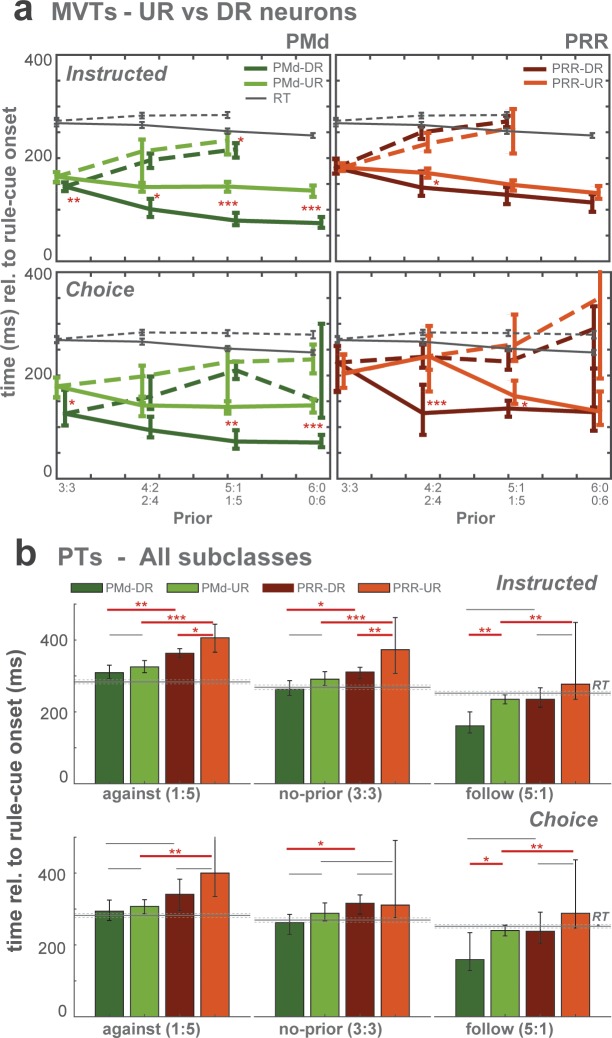
Selection-signal latencies between DR and UR neurons of PMd and PRR.(a) Comparisons of MVTs between DR and UR neurons in PMd (left) and in PRR (right). Instructed trials are shown on the left column and choice trials on the right. Solid lines indicate follow trials and dashed lines indicate against trials. RTs are also shown with MVTs. (*p < α at 5%, **p < α at 1%, ***p < α at 0.1%; permutation test). (b) Comparisons of plateau times (PTs) of neural distances relative to rule-cue onset. Zero-prior (3:3) and one high-prior (5:1) conditions, against and follow trials separately, are shown. Latency differences were tested between neural subclasses within each area (e.g. PMd-DR vs PMd-UR) and between areas only within the same neural subclasses (e.g. PMd-DR vs PRR-DR), depicted by horizontal gray and red lines above the bar plots (*p < α at 5%, **p < α at 1%, ***p < α at 0.1%; permutation test).